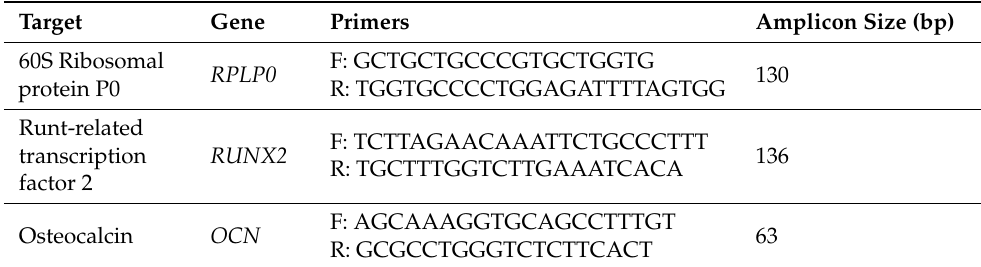
Table 1. List of primers used in present